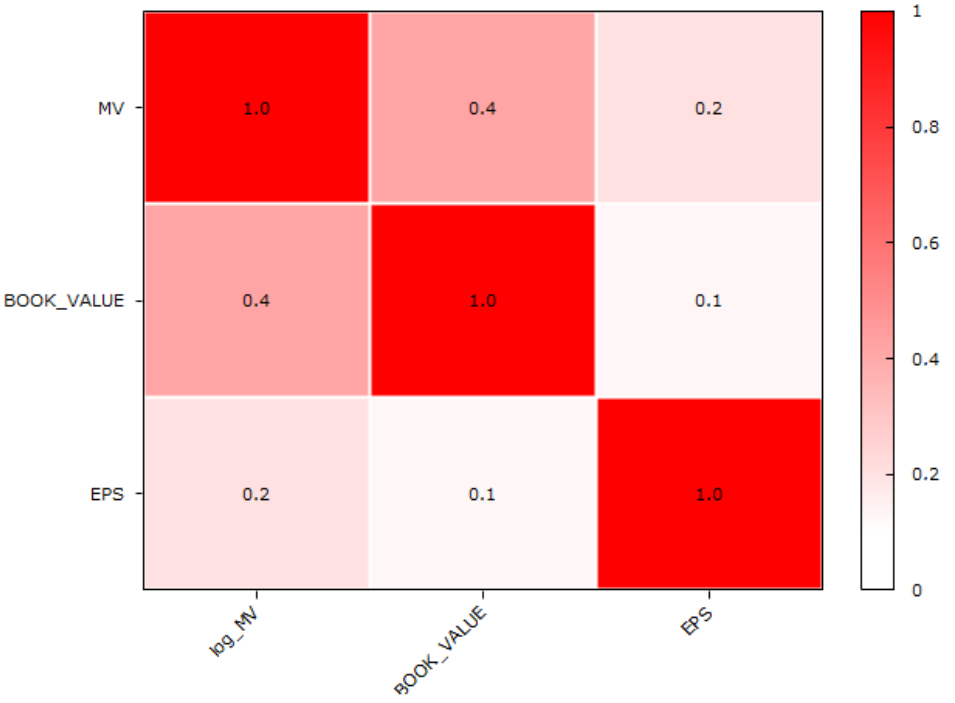
Figure 1. Correlation matrix. Source: built on the basis of the authors’ calculations.